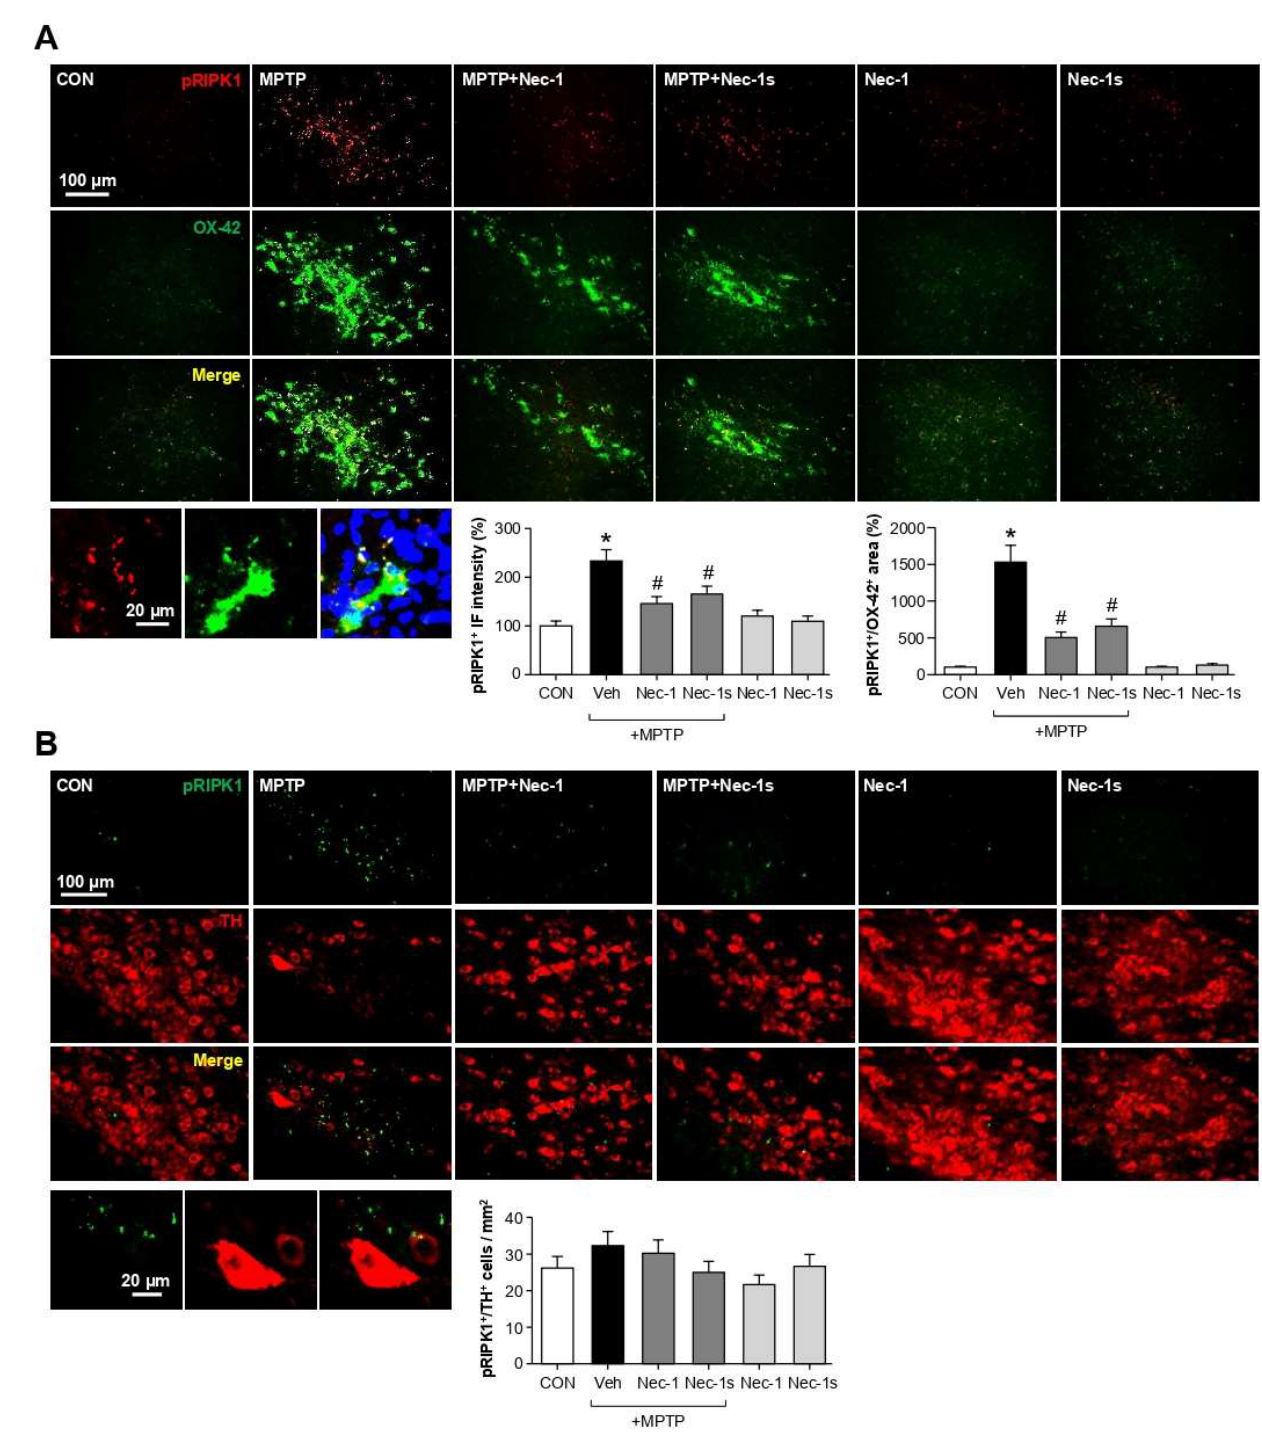
Figure 8. Effect of Nec-1 and Nec-1s on p-RIPK1 (Ser 166) in the brains of MPTP-injected mice. ( A ) Double IF staining for p-RIPK1 Ser 166 (red) with OX-42 (green, microglial marker) in the SN of MPTP-injected mice. Representative images are shown in the upper panel, and quantifications of p-RIPK1 positive intensity and p-RIPK1/OX-42 positive colocalization are shown in the bottom panel. ( B ) Double IF staining for p-RIPK1 Ser 166 (green) and TH (red, dopaminergic neuronal marker) in the SN of MPTP-injected mice. Representative images are shown in the upper panel, and quantification data of the p-RIPK1/TH positive colocalization is shown in the bottom panel. Data are shown as the mean ± SEM. * p < 0.05 vs. control group; # p < 0.05 vs. MPTP group.